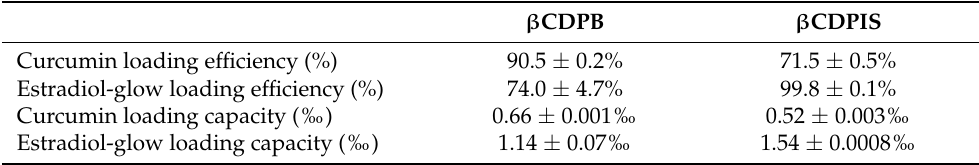
Figure 5. Complexation study of curcumin (cur) and estradiol-glow (est) from aqueous solutions by 20 mg β CDPIS and β CDPB (data are presented as means ± SD, n = 3). BCDPIS-est: estradiol-glow complexed with BCDPIS; BCDPIS-cur: curcumin complexed with BCDPIS; β CDPB-est: estradiol- glow complexed with β CDPB; β CDPB-cur: curcumin complexed with β CDPB. Table 2. The loading efficiency and loading capacity of curcumin and estradiol-glow (data are presented as means ± SD, n = 3).